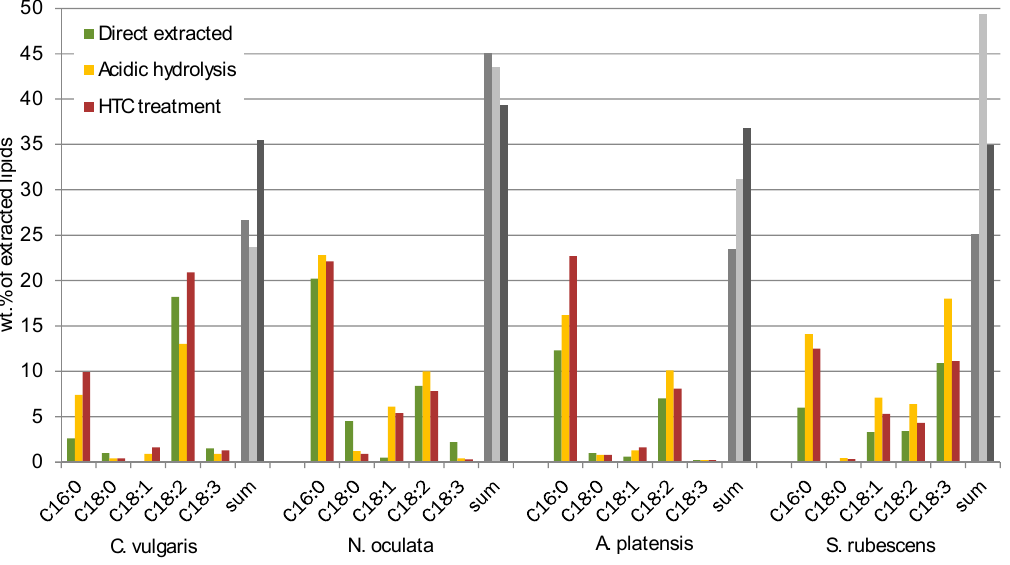
Figure 6. wt % of main fatty acids and percentage of recognized fraction of the different algae species.